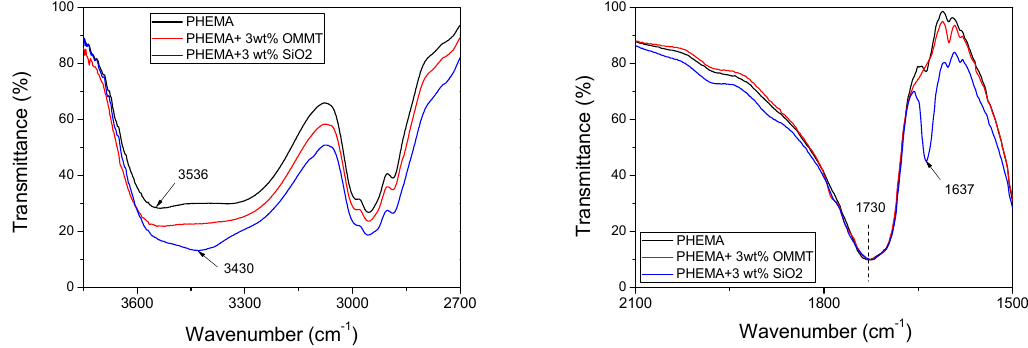
Figure 13. Details of the FTIR spectra of neat PHEMA and PHEMA nanocomposites with 3 wt % OMMT or 3 wt % silica in the region 3750–2700 cm − 1 ( a ) and 2100–1500 cm − 1 ( b ).